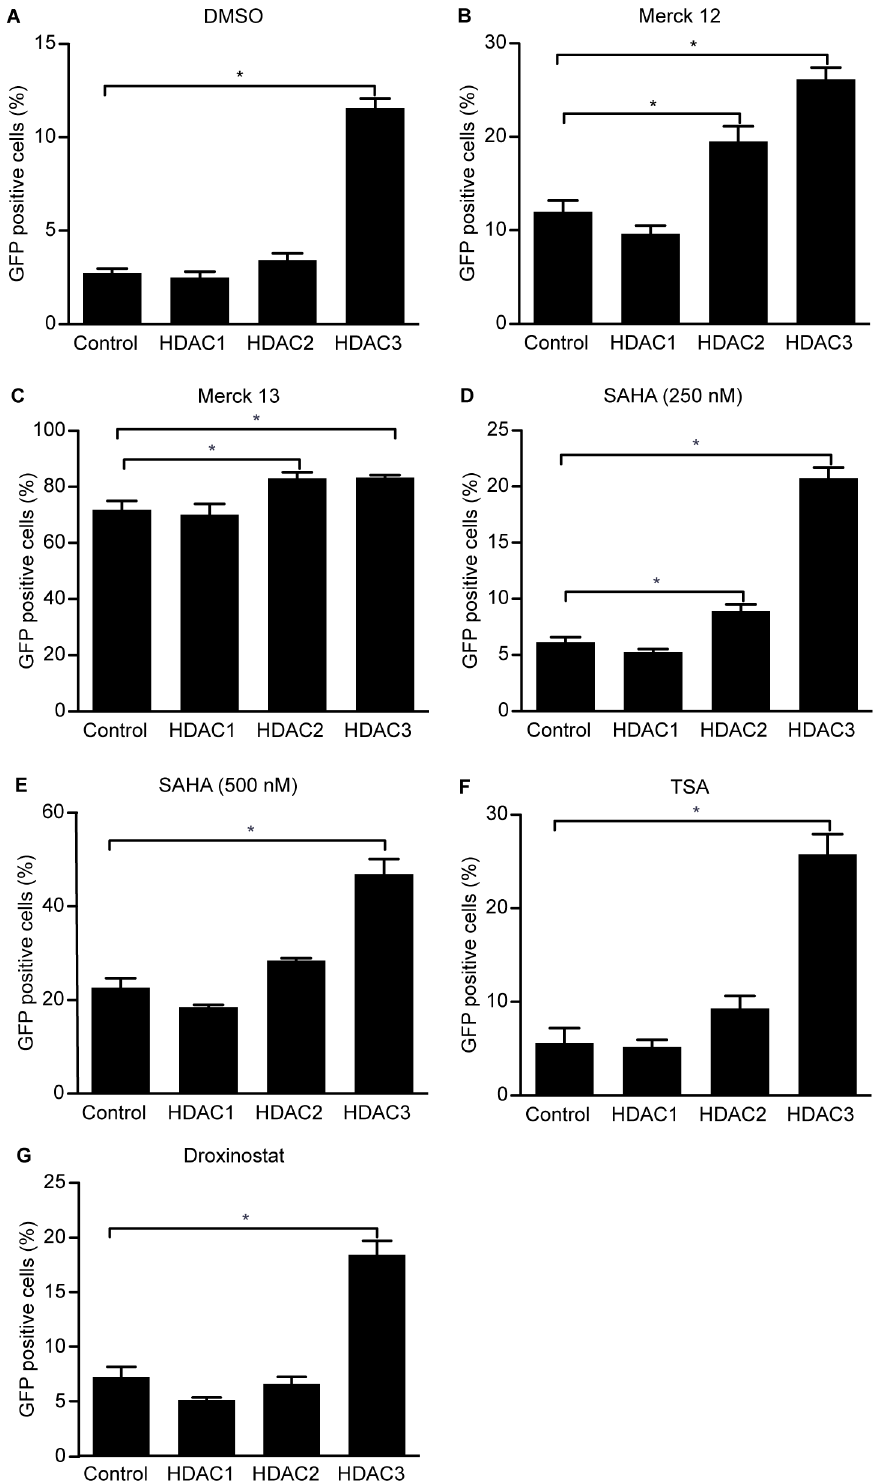
Figure 4. Chemical inhibition of HDACs following depletion of HDAC3 significantly increases expression from the HIV-1 promoter. A. 2D10 cell that had been depleted of HDAC1, 2 2, or 2 3 or had been infected with the scrambled control lentivirus were exposed to 0.015% DMSO as the vehicle control for 24 hours. B. Chemical inhibition of HDAC1 and 2 2 using Mrk 12 (20 m M) does not result in a significant increase in the percentage of 2D10 cells expressing GFP following depletion of HDAC1 or 2 2. However, similar to depletion of HDAC3 alone, a significant increase in the percent of cells expressing GFP was observed when Mrk 12 was added to cells depleted of HDAC3. C. Chemical inhibition of HDAC1, 2 2 and 2 3 with Mrk 13 (200 nM) resulted in a significant increase in the percent of GFP positive 2D10 cells in cells depleted of HDAC2 or 2 3, but not HDAC1. D. A submaximal (250 nM) concentration of SAHA resulted in a significant increase in the percent of cells expressing GFP following depletion of HDAC2